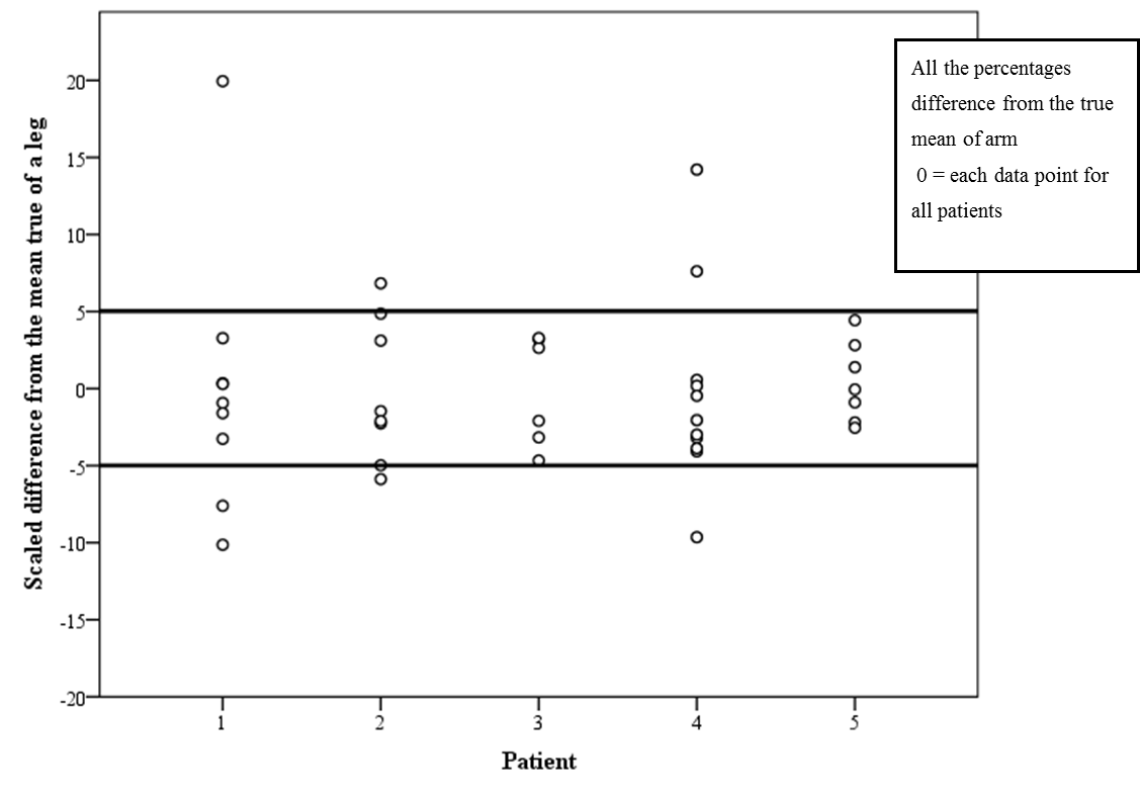
Figure 6. Scaled difference from the true mean of leg measurements for each PT with cutoff points at ±